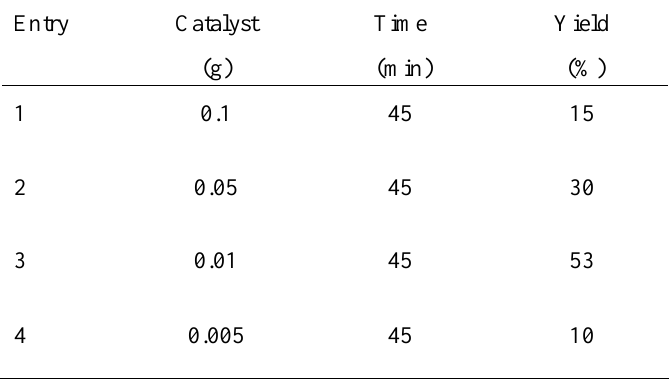
H nanoparticles 3